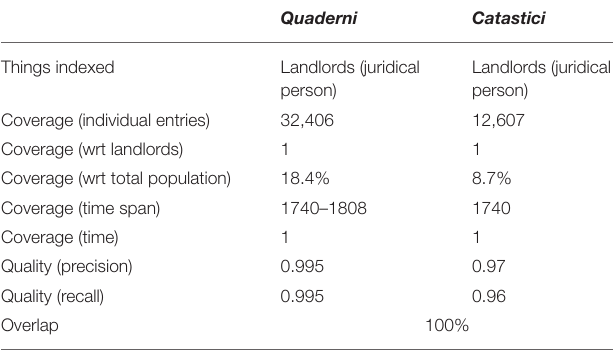
TABLE 1 | Summary of the comparison of the Quaderni and Catastici .